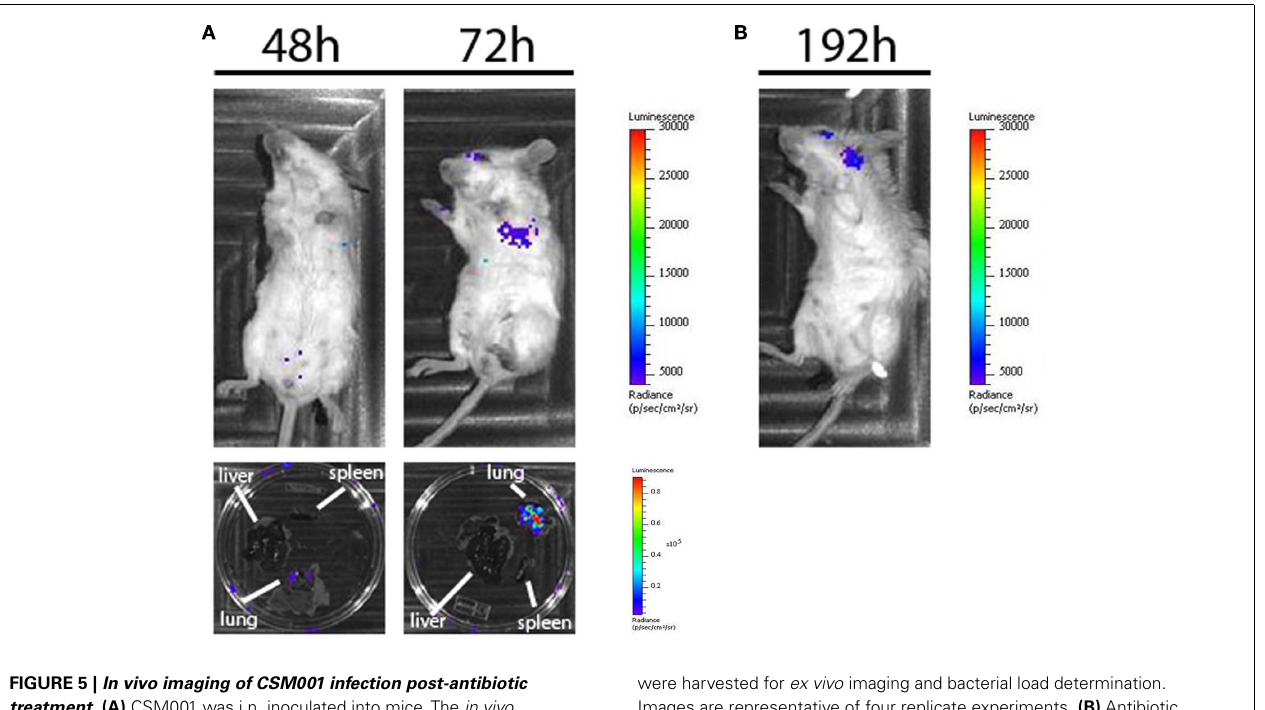
FIGURE 5 | In vivo imaging of CSM001 infection post-antibiotic treatment. (A) CSM001 was i.n. inoculated into mice.The in vivo bioluminescence was monitored at 24, 48, and 72h post-infection. Treatment with 20mg/kg of levofloxacin was administered after the 24-h time point. At each time point an animal was sacrificed and organs